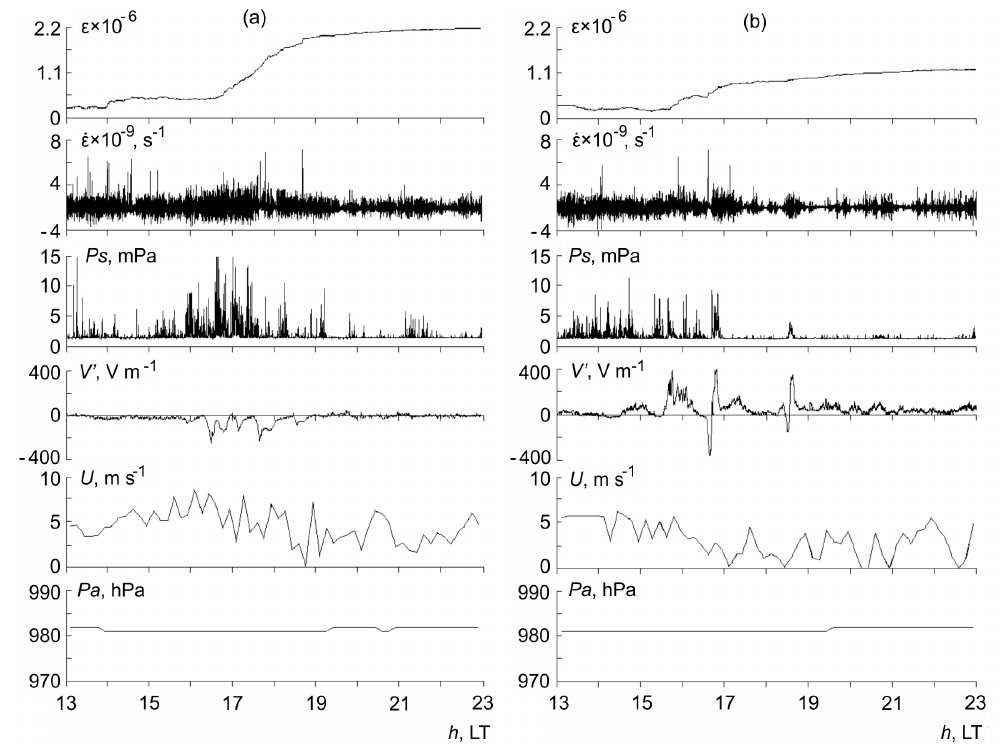
Figure 7. Behavior of the near-surface rocks relative deformation ε , its rate ˙ ε , acoustic pressure P s in the frequency range of 0.7–2.0 kHz, atmospheric potential gradient V (cid:48) , wind velocity U , air pressure P a on 14 ( a ) and 16 ( b ) October 2009. Increase of ε corresponds to rocks